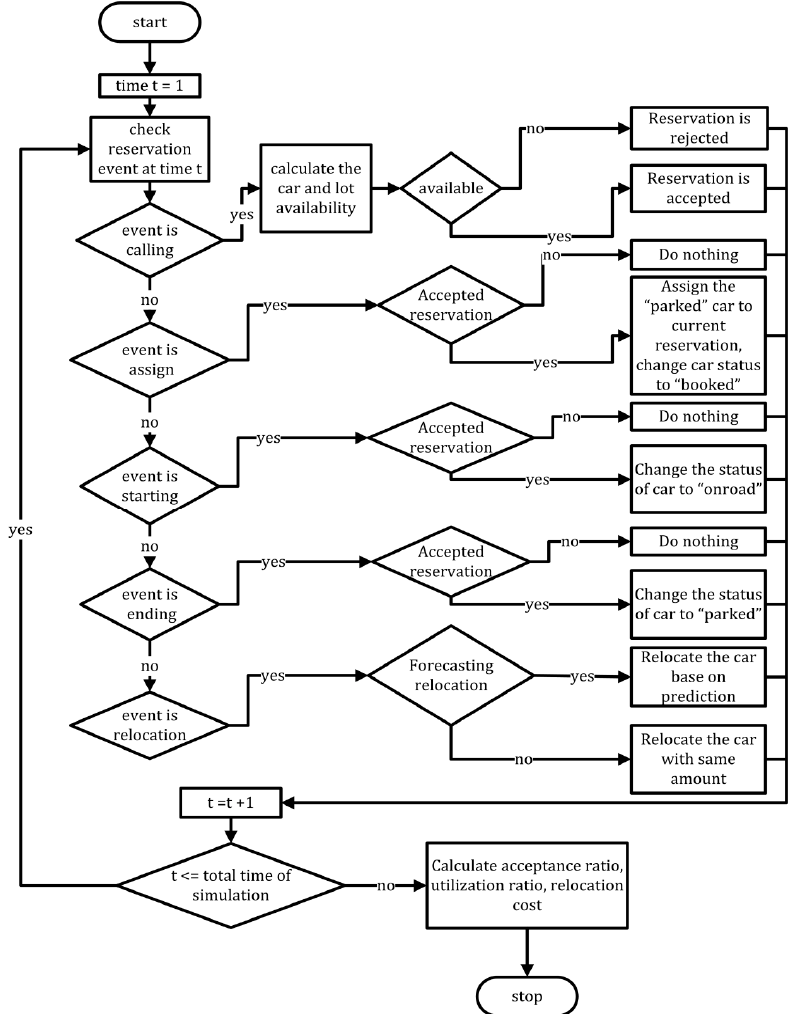
Figure 5. Flow chart for reservation based one-way simulation.